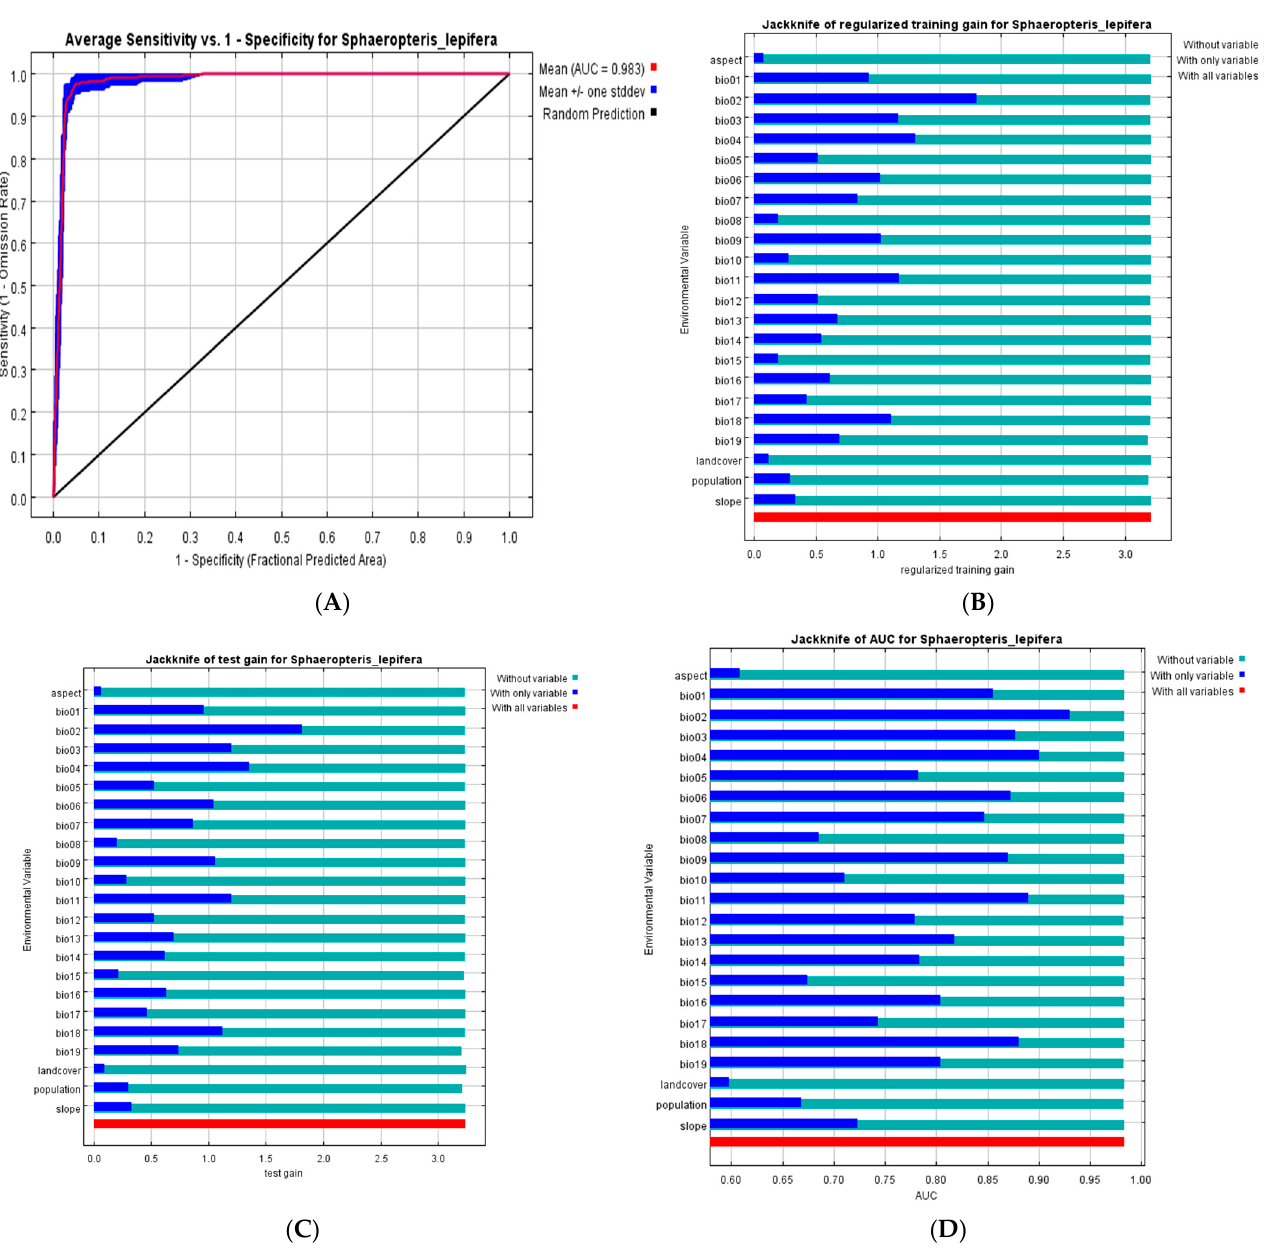
Figure 2. ( A ) ROC curve for MaxEnt prediction; ( B ) Result of the jackknife test of variable importance using training gain; ( C ) Result of the Jackknife test using test gain; ( D ) Result of the jackknife test using AUC on test data.